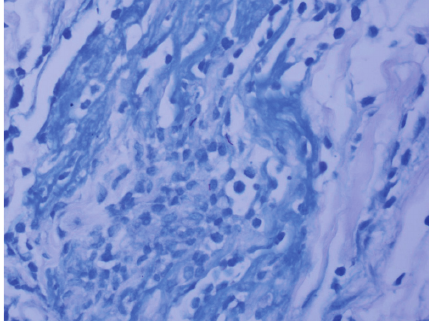
F 5: e le hand with irrigation system consisting of a pediatric feeding tube size number 5 Fr inserted into the synovial sheath with open-tube drainage. Loosely sutured skin to allow drainage.